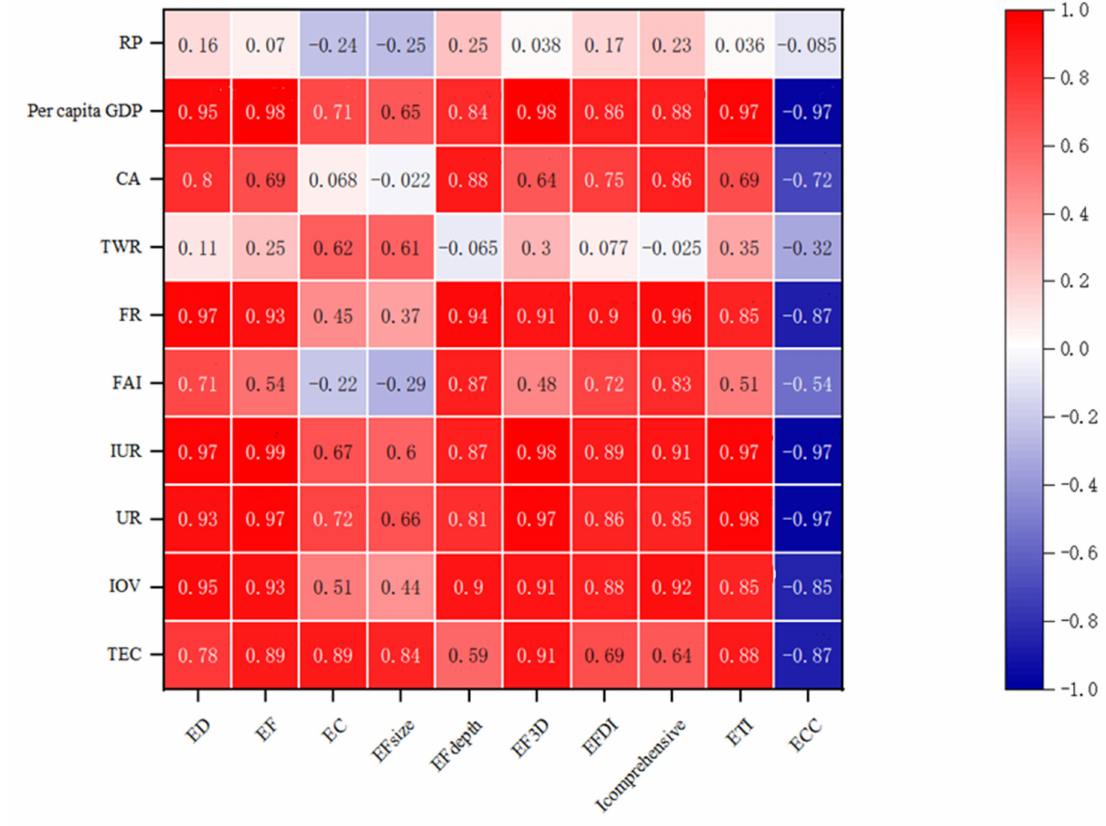
Figure 10. Correlation matrix analysis of ecological security evaluation indexes in the upper reaches of the Yellow